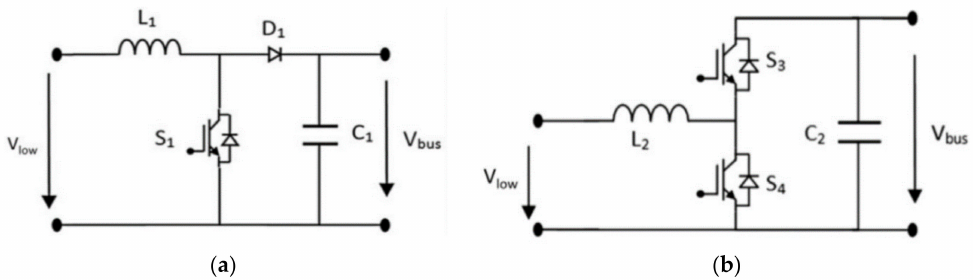
Figure 1. Converter simplified layout: ( a ) DC / DC boost converter; ( b ) DC / DC buck-boost